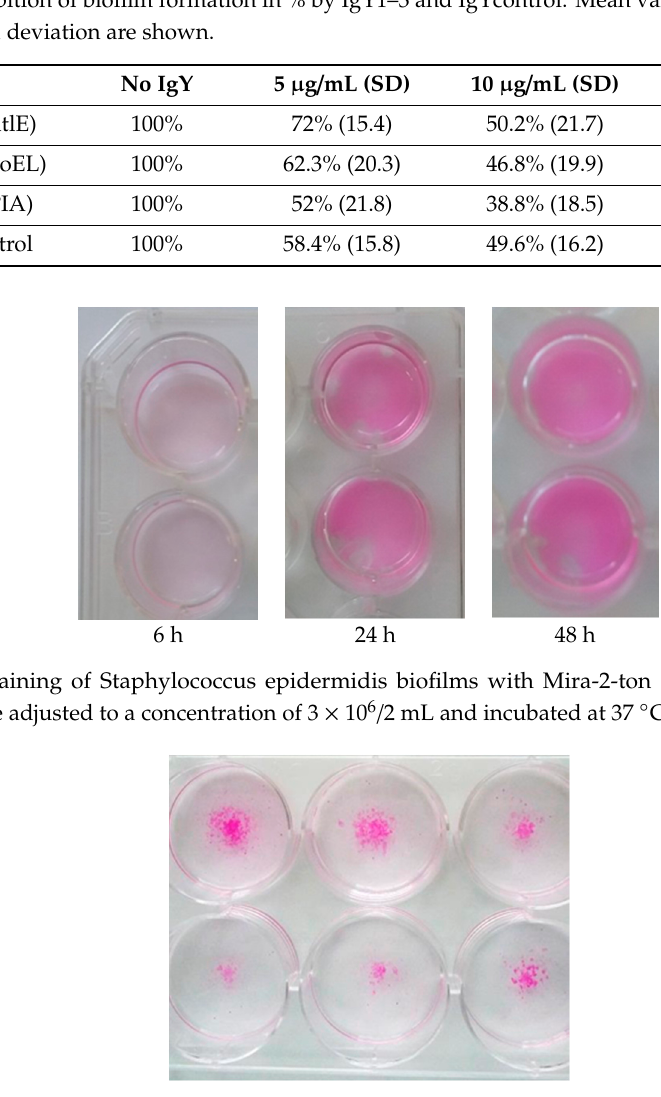
Figure 2. Staining of Staphylococcus epidermidis biofilms after 24 h incubation with IgY3 (10 µg/mL). Biofilm formation was significantly reduced when compared to results after 24 h incubation without antibodies as shown in Figure 1.